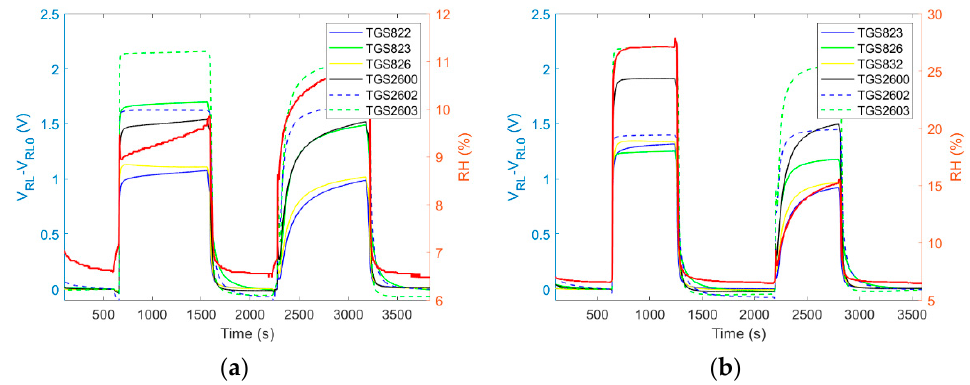
Figure 10. ( a ) Gas sensor responses to dried air, which contained ethanol vapors when: (left) sample was transferred directly to the measuring device and (right) and sample passed the Nafion dryer prior to measurement. ( b ) Gas sensor responses to humid air, which contained ethanol vapors when: (left) sample was transferred directly to the measuring device and (right) and sample passed the Nafion dryer prior to measurement.